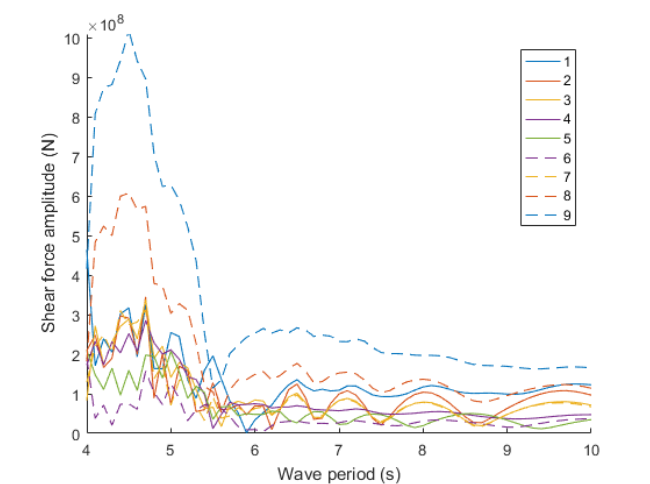
Fig. 15. Shear forces in the heave direction are greatest at the one or two most downstream joints. Wave heading angle: 80°. Joints are numbered from fore to aft (see legend).